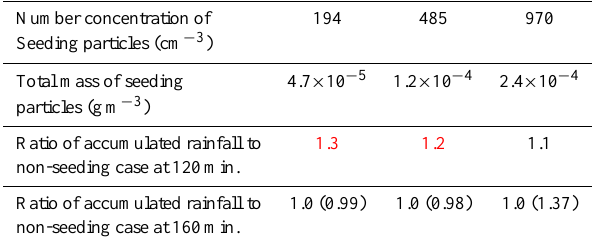
Table 8. Ratios of seeded-case to non-seeded-case accumulated sur- face rainfall averaged over the domain at 120 and 160min. Seeding of stratiform cloud is carried out with flare particles (up to 5µm in radius). A ratio indicating an increase is colored red. Ratios of seeded-case to non-seeded-case (180cm − 3 ) cloud droplet number concentrations at 100m above the base of the cloud center at 62min are shown in parentheses.